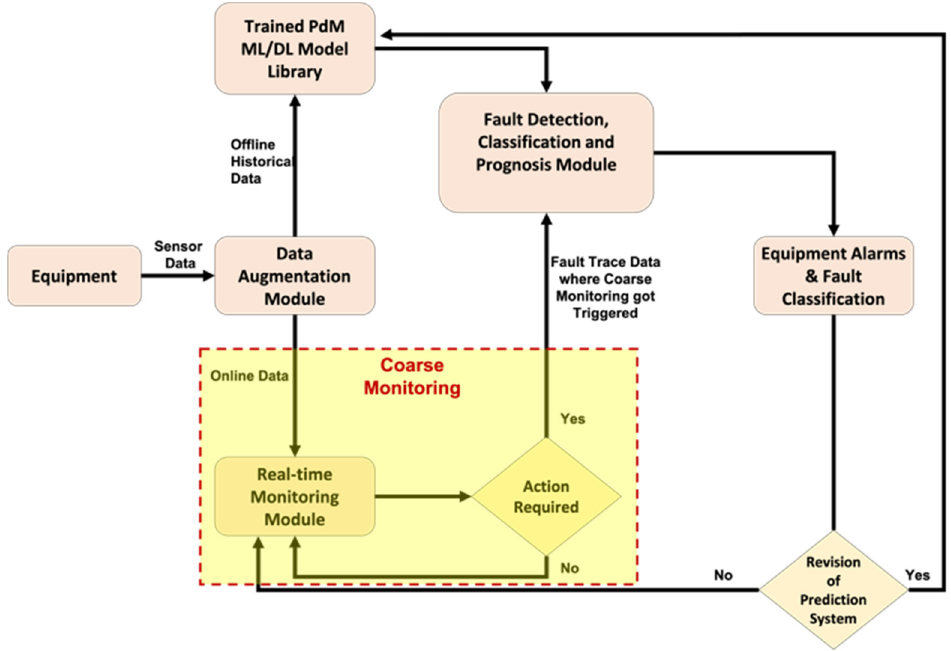
Figure 10. The implemented predictive maintenance system’s business process and decision-making strategy for fault prediction and maintenance applications .